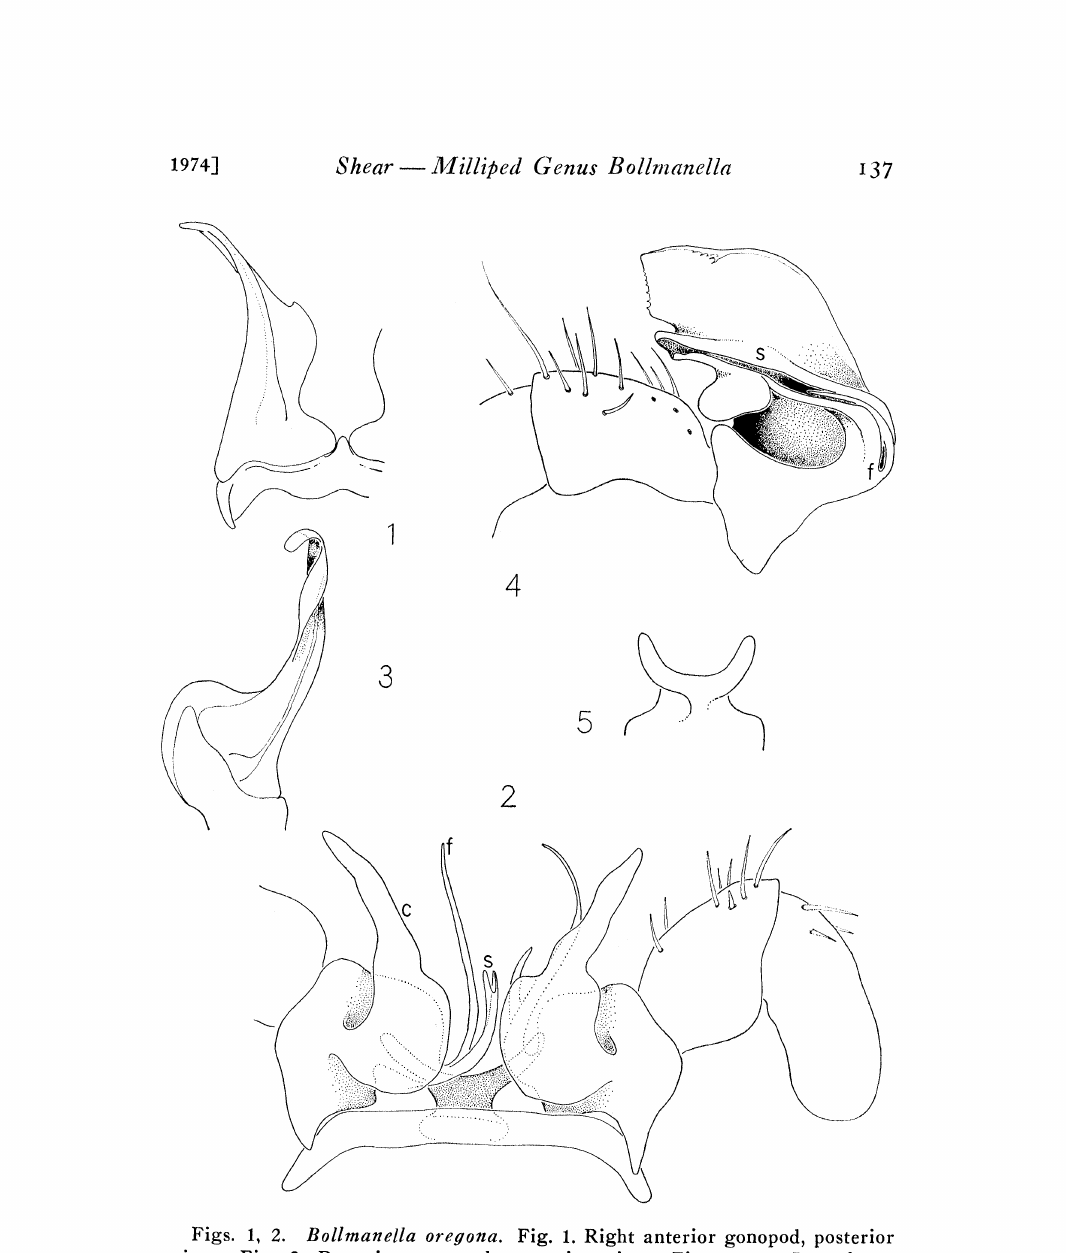
Figs. 1, 2. Bollmanella oregona. Fig. 1. Right anterior gonopod, posterior view. Fig. 2. Posterior gonopods, anterior view. Figs. 3, 4. B. reducta. Fig. 3. Left anterior gonopod, posterior view. Fig. 4. Right posterior gonopod, posterior view. Fig. 5. Sternal process between posterior gono- pods of B.